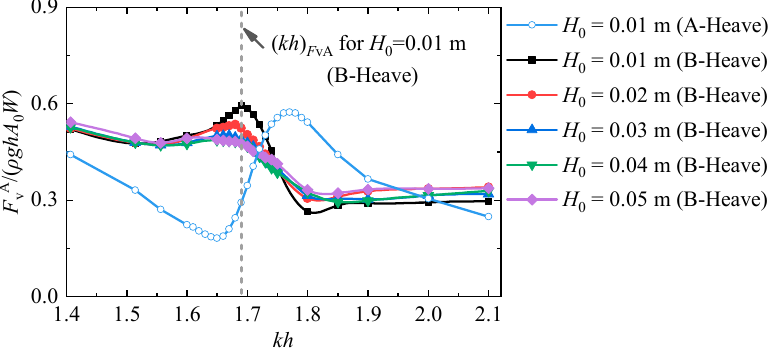
Figure 10. Variations of the normalized vertical wave force on Box A for the B-Heave structure system. The results for the A-heave structure system with H 0 = 0.01 m is also shown for comparison. Secondly, for the B-Heave structure system, the normalized maximum vertical wave force on Box A shows a downward trend with the incident wave height. Figure 11 fur- ther demonstrates the variations of the normalized largest vertical wave force on Box A, [ F vA /( ρ ghA 0 W )] max , with respect to H 0 for both the A-Heave and B-Heave structure sys- tems. For both structure systems, the values of [ F vA /( ρ ghA 0 W )] max , decrease monotonically with H 0 . Besides, [ F v A /( ρ ghA 0 W )] max for the B-Heave structure system is shown to be always higher than the corresponding one for the A-Heave structure system.